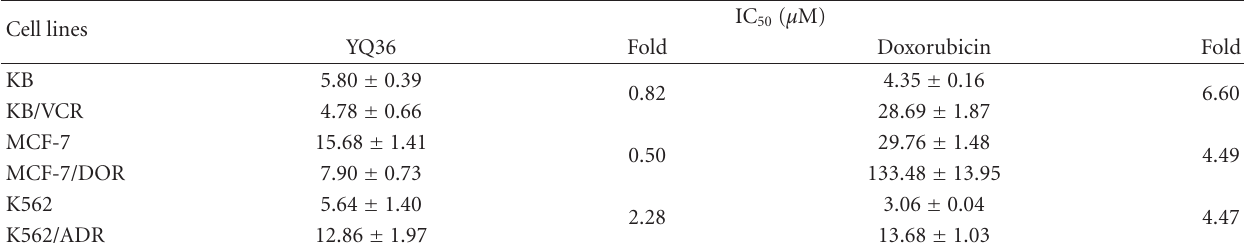
Table 1: The IC 50 values of YQ36 and DOX on three panels of chemosensitive tumor cell line and their chemoresistance subline. The fold indicated the index of IC 50 on chemoresistance subline versus chemosensitive cell